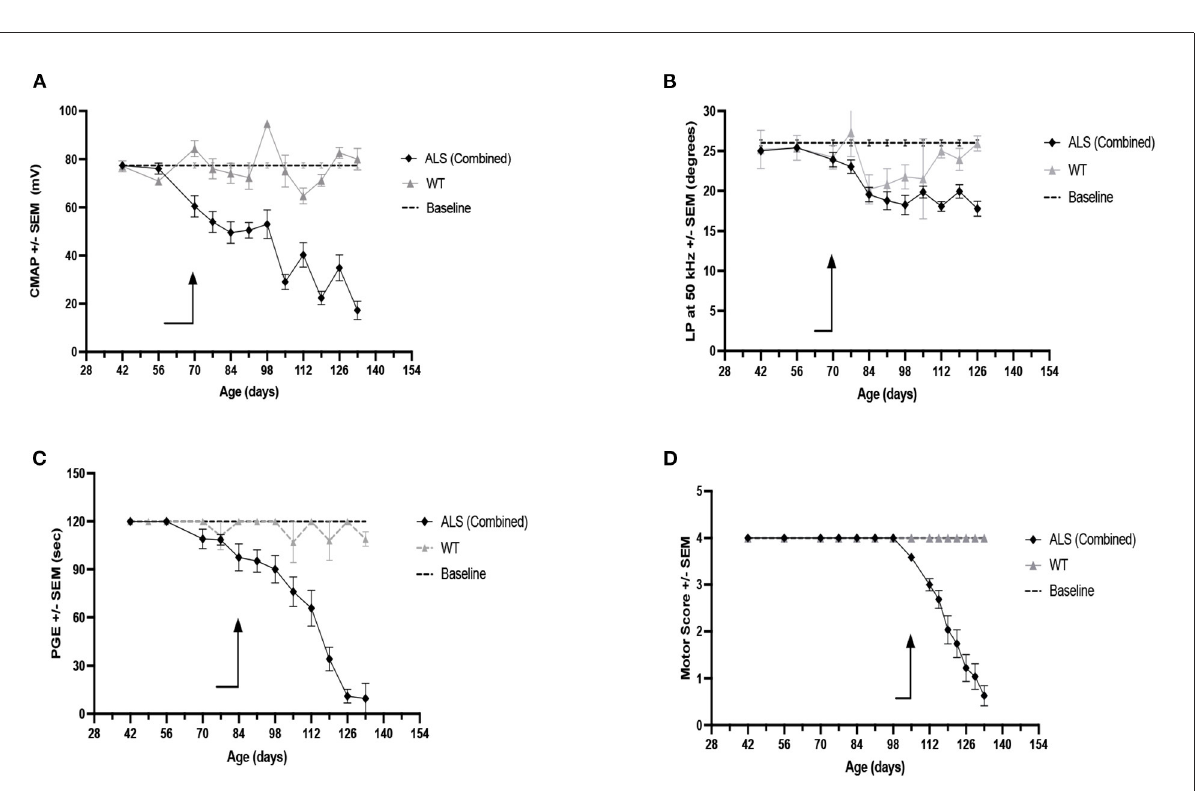
FIGURE4 Weekly measures for Combined RSV-treated (F + M) and untreated (F + M) ALS mice vs. combined WT (F + M) biomarker values and vs. each biomarker baseline values. (A) CMAP amplitude. (B) LP 50kHz. (C) PGE. (D) Motor score. Arrows indicate time of first consistent significant difference from baseline values for that